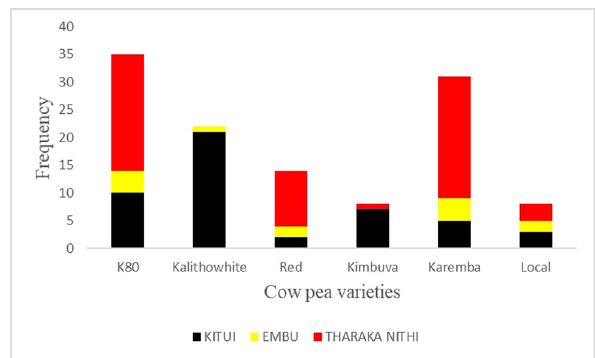
Figure 4: The dominant cowpea varieties grown in the three counties. K80, Red, Karemba, and Local varieties were commonly grown in all three counties, albeit with varying degrees of frequency. Majority of the farmers in Tharaka grew K80, Karemba, and Red